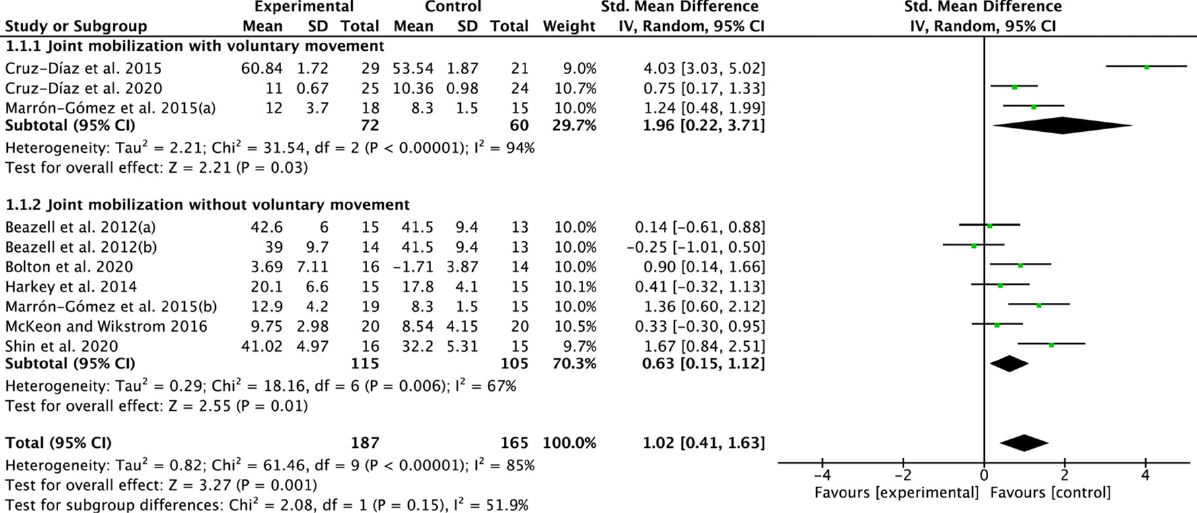
Figure 3. Forest plot on the effect of joint mobilization on dorsiflexion range of motion. Beazell et al. 2012(a) [18], proximal tibiofibular joint mobilization; Beazell, et al. 2012(b) [18], distal